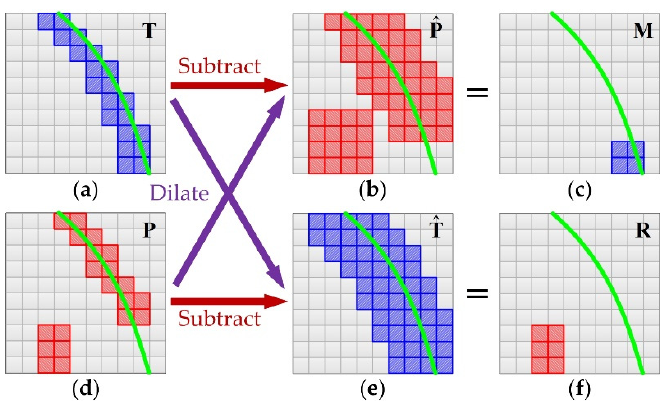
Figure 4. The calculation process of DC loss. ( a ) Ground truth; ( b ) dilated probability map; ( c ) missing contour; ( d ) probability map; ( e ) dilated ground truth; ( f ) redundant contour.